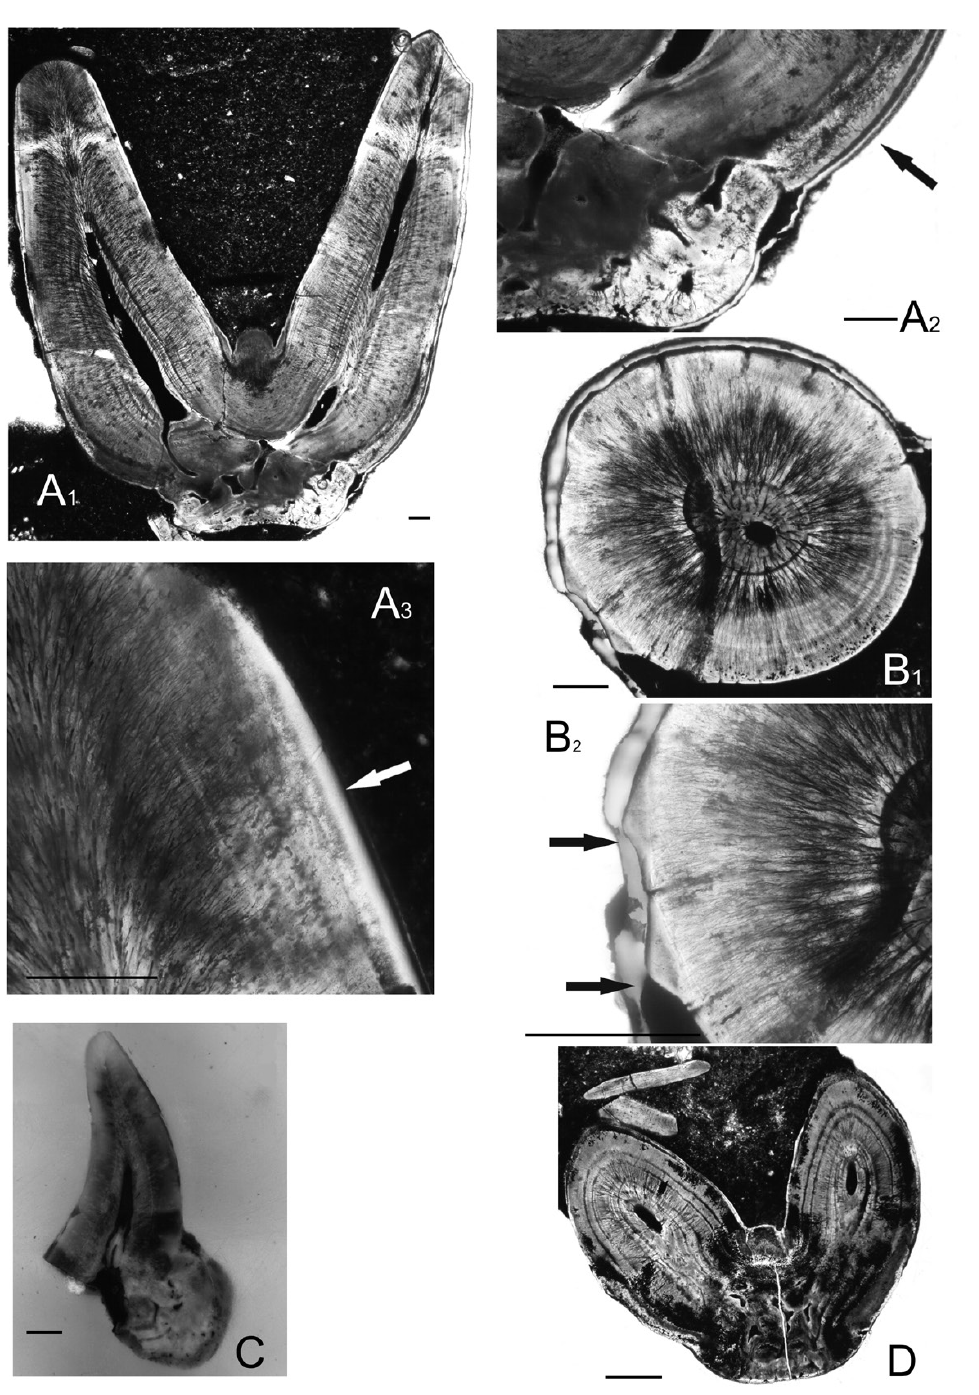
Figure 4 - Xenacanthus ragonhai sp. nov. from the Rio do Rasto Formation, Wordian to Wuchiapingian, Brazil teeth histology. A , MCN.P.1125, A : longitudinal section through the lateral cusps, A : arrow points to the trabecular dentine overlaping externally 1 2 to the orthodentine on the basal portion of lateral cusps, A : arrow points to a detail of the thin enameloid layer; B , MCN.P.1126a, 3 transversal section through a lateral cusp (B ) and the arrow points to the few smooth cristae of enameloid (B ), C , MCN.P.1126b, 1 2 polished section through a lateral cusp showing a small projection of trabecular dentine; D , MCN.P.1127, obliquous longitudinal section through a teeth Scale bars A-B = 200 μm C-D = 500